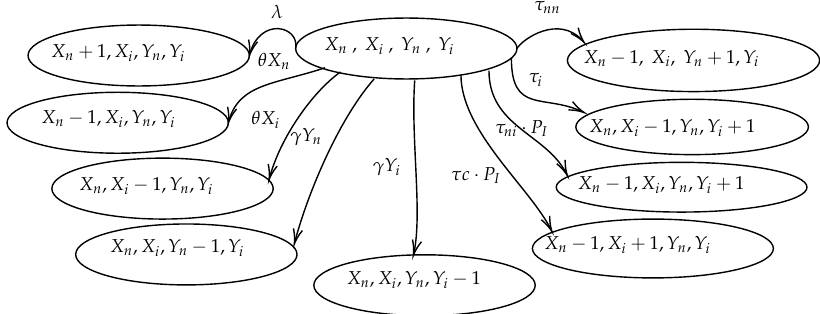
Figure 6. Markov chain of the infection process in a P2P system with